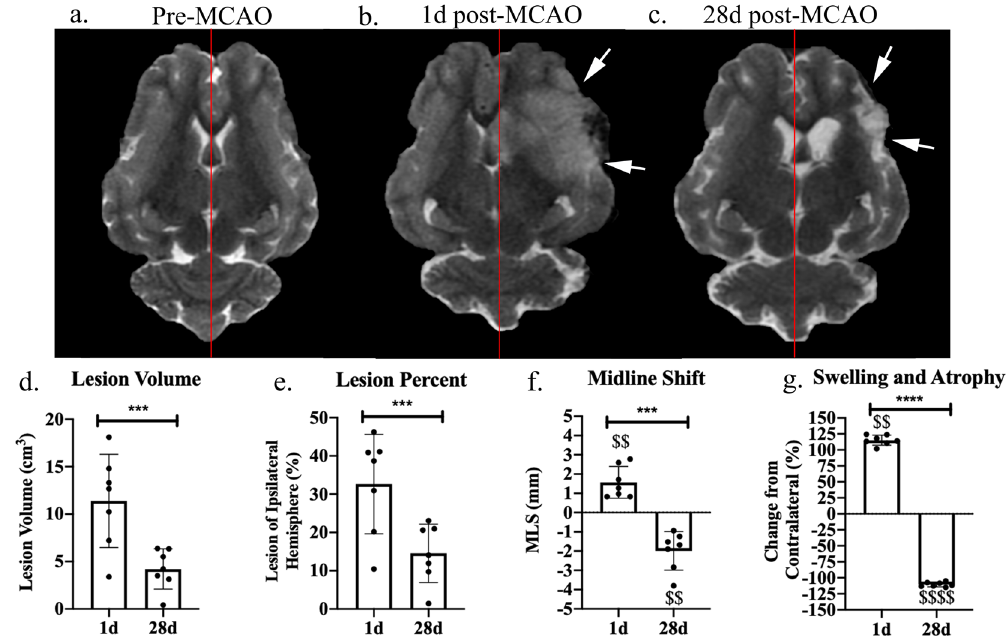
Figure 1. Canonical MRI measurements of MCAO induced ischemic stroke at 1d and 28d post-MCAO. T2W images prior to MCAO reveal homology between the hemispheres ( a ). At 1d ( b ) and 28d ( c ) post-MCAO, T2W images exhibited territorial hyperintense lesions indicated by white arrows and a shift from the natural midline (red lines indicate natural midline). Lesion volume ( d ), lesion volume as a percent of the ipsilateral hemisphere ( e ), midline shift (MLS) ( f ), and hemispheric changes ( g ) were quantified at 1d and 28d post-MCAO. *** and **** indicated statistically different between timepoints. $$ and $$$$ indicated statistically different from hypothetical